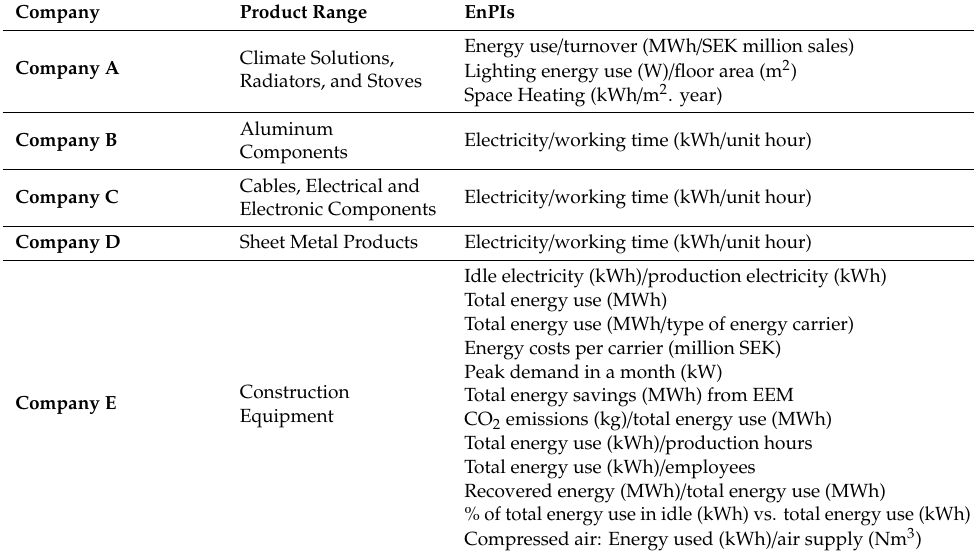
Table 3. Collected EnPIs for the engineering industry.